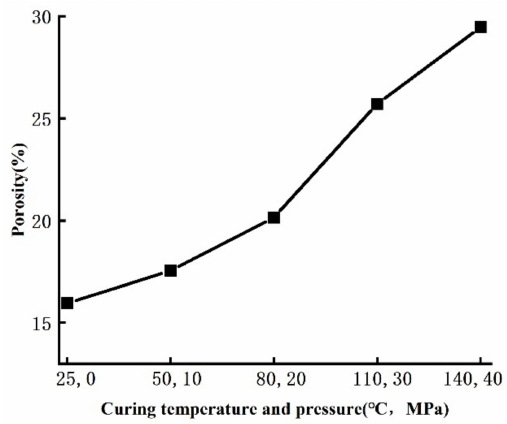
Figure 12. Porosity of cement stone under different curing temperatures and pressures.